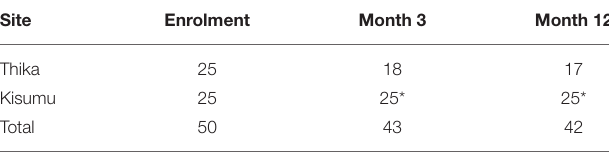
TABLE 1 | Number of interviews by time period.